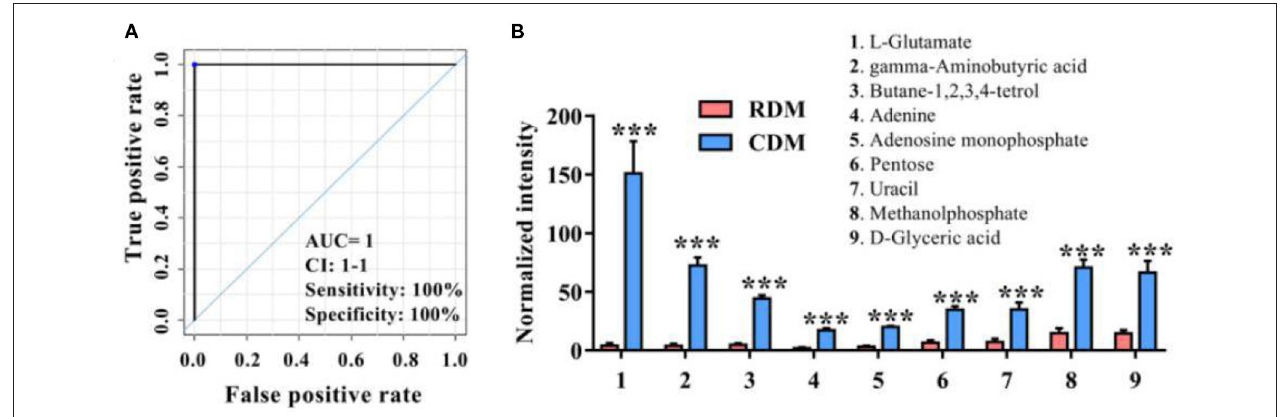
FIGURE 2 | Potential metabolic marker compounds in cooked and raw donkey muscles. (A) Receiver operating characteristic curve of (B) . (B) Normalized intensity for potential metabolic marker compounds in RDM and CDM. Data are presented as means ± SEM ( n = 6), *** p < 0.001. AUC is the area under the ROC curve; CI 1–1 is the lower and upper limit of the AUC confidence